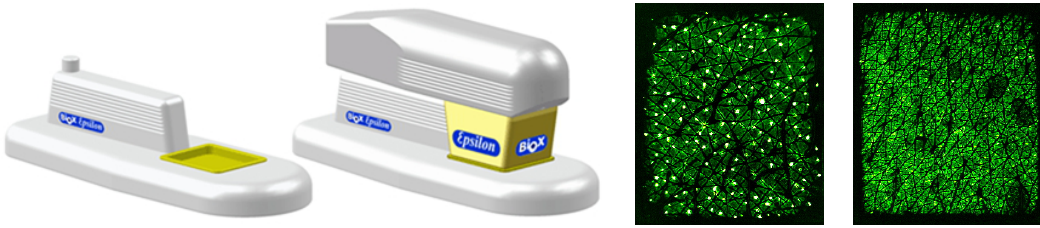
Figure 2. Epsilon TM E100 multi-sensor corneometer ( left ) and sample scans ( right ).